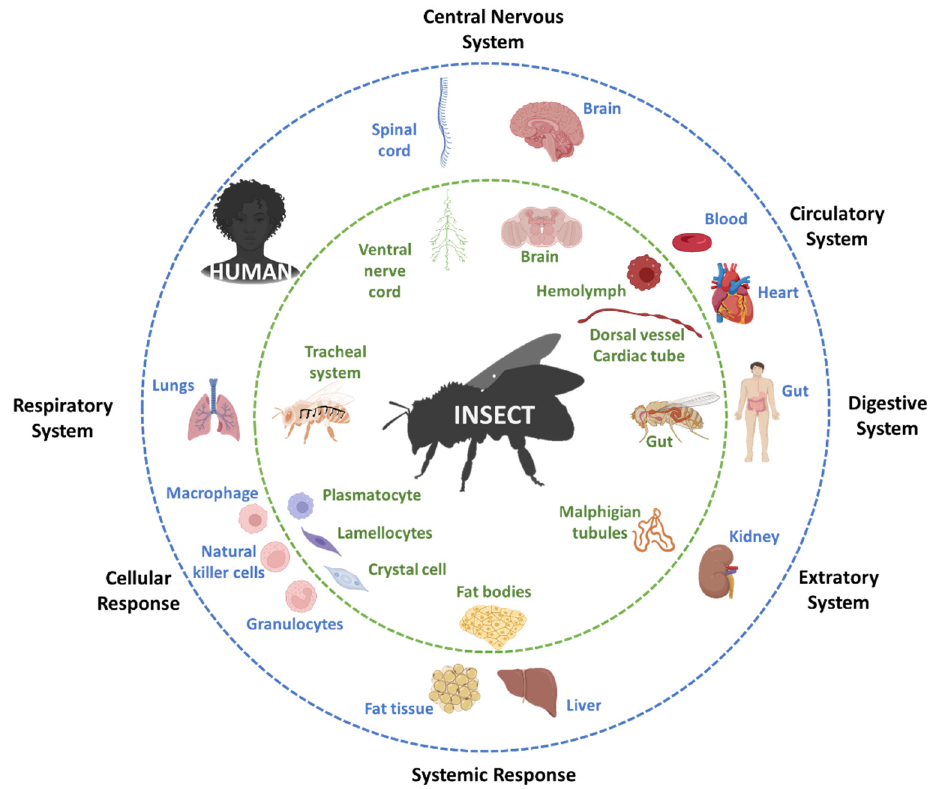
Figure 2. Conserved biological systems in insects and humans.